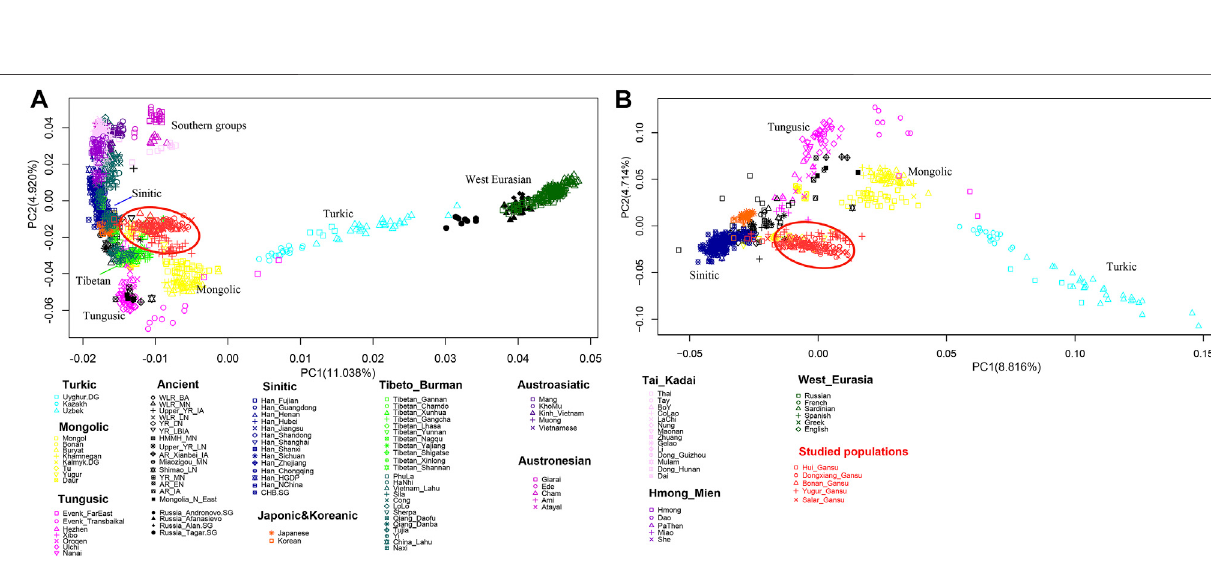
FIGURE 3 | Patterns of genetic relationship among published East Asian populations and our newly genotyped fi ve populations inferred from the principal component analysis. (A) East Asians including southern populations and with the West Eurasians; (B) East Asians without southern populations and without the West